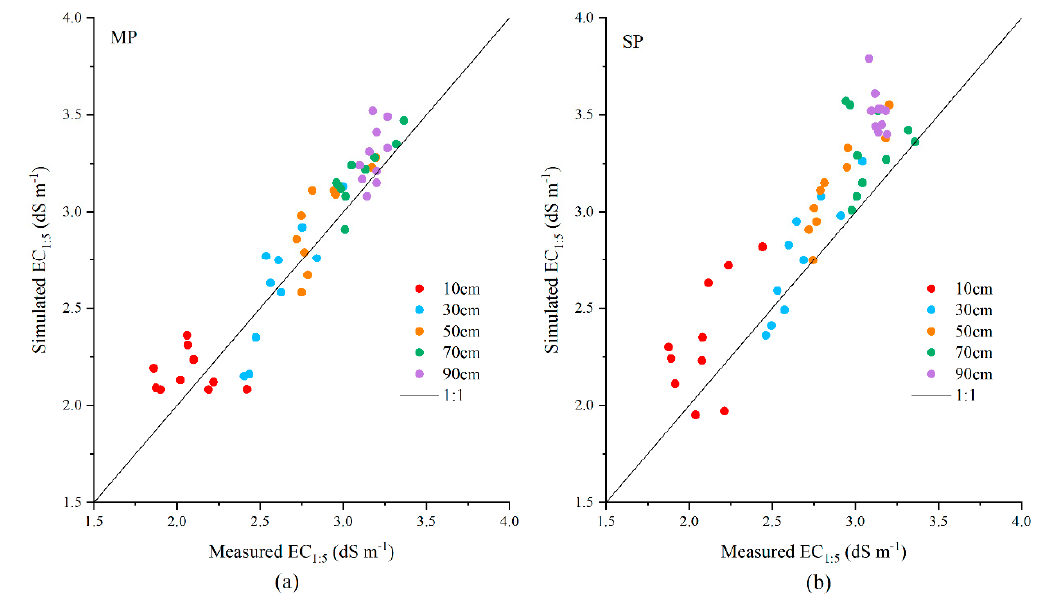
Figure 3. Comparison of measured and simulated EC values in different soil depth (10, 30, 50, 70, 90 cm). ( a ) MP indicate the calibration based on the field-measured data at the middle position of the experimental lysimeter. ( b ) SP indicates the calibration based on the field-measured data at the middle position of the experimental lysimeter. Table 2. Statistical errors parameters (RMSE, MAE, ME, R 2 ) for the comparison between measured and simulated soil water content and salt concentration (EC 1:5 ) for D2W2 treatments. Soil Water Content